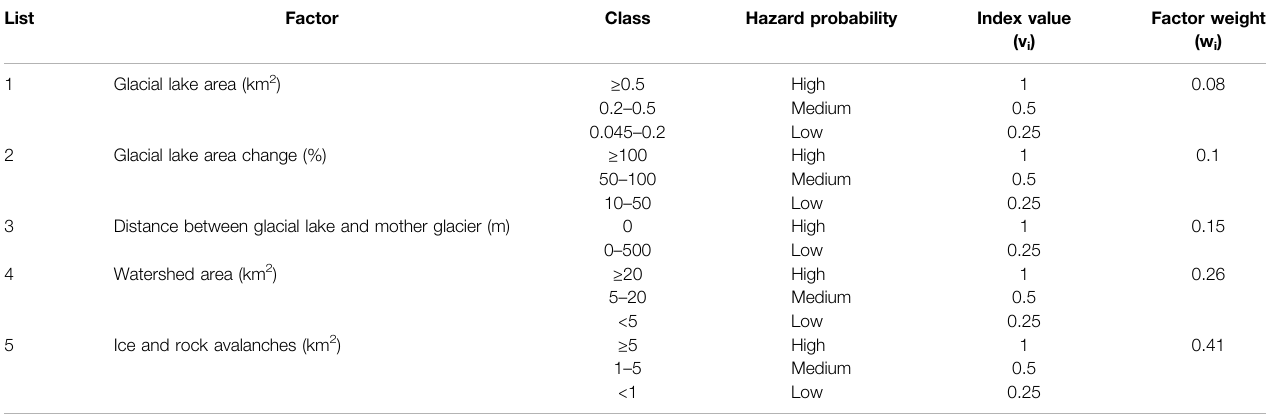
TABLE 2 | Selected factors with classes and associated index